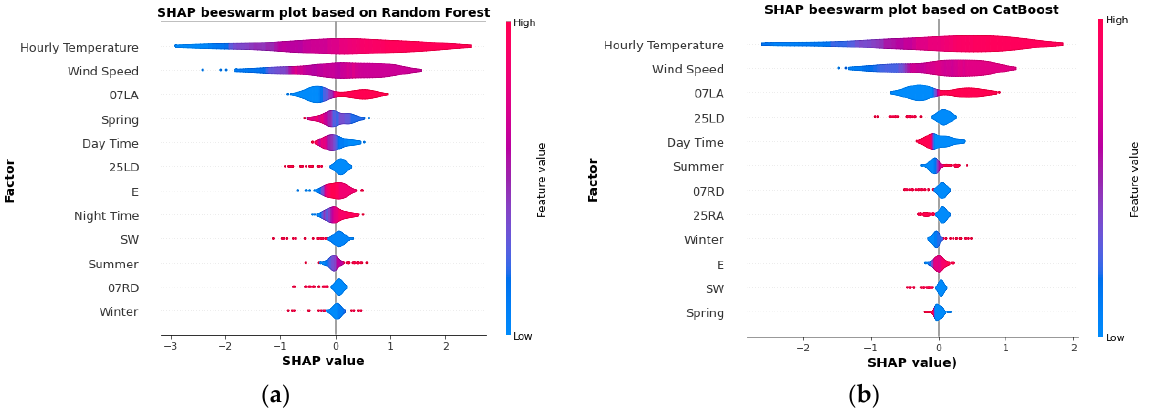
Figure 11. SHAP beeswarm plots: ( a ) Random Forest; ( b ) CatBoost.